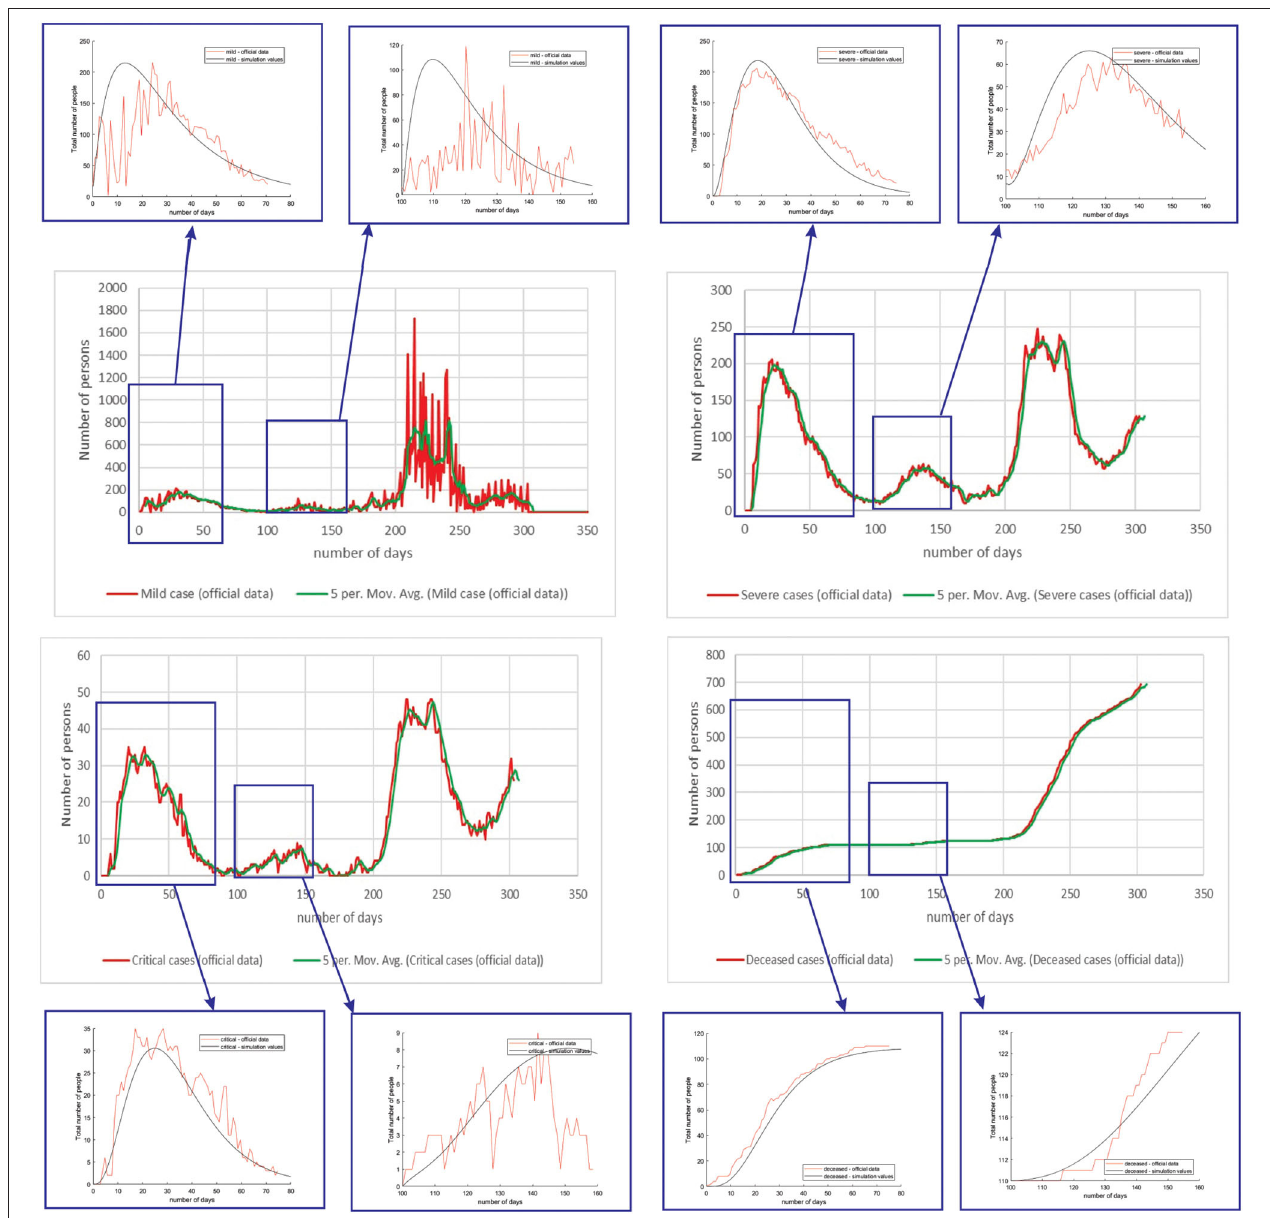
FIGURE 9 | Comparison of real and simulated values for the four categories of interest (Luxembourg), mild infection, severe infection, critical infection, and deceased